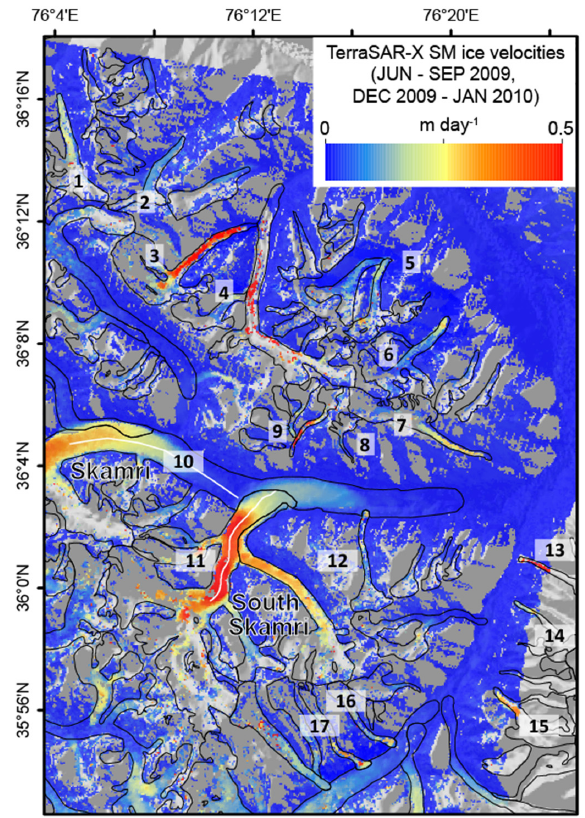
Figure 6. Surface velocities derived from TerraSAR-X SM image pairs (16 June–12 September 2009 and 24 December 2009–15 Jan- uary 2010) in the central Shaksgam Valley, Sarpo Laggo and Skamri basins. Numbers indicate glacier catchments mentioned in the text and in Table 3. The centerlines of the Skamri and South Skamri glaciers are marked as white lines. Background: SRTM